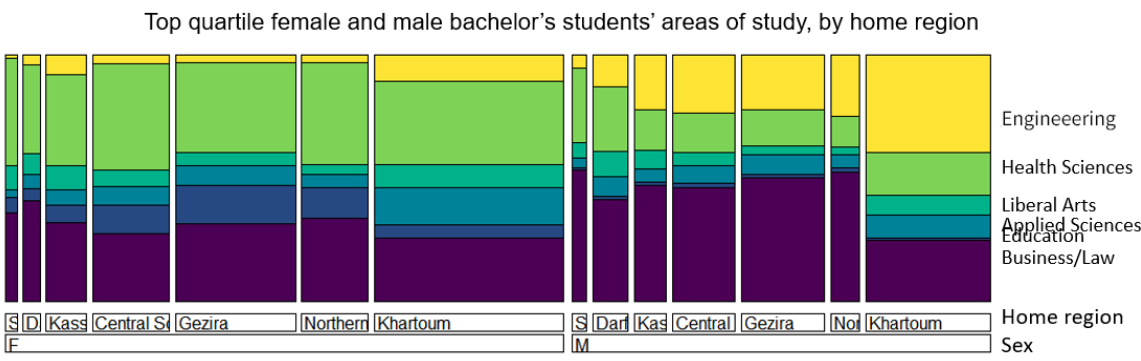
Figure 23. Double-decker plot of department category distributions by home region, for entering female and male bachelor’s students in the top quartile of academic